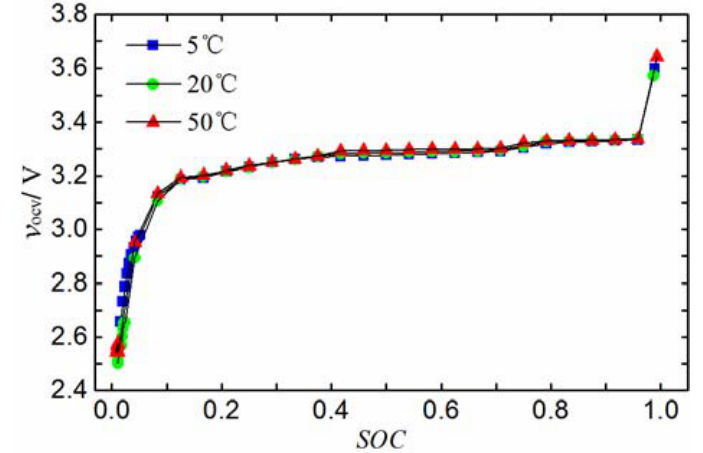
Figure 2. OCV–SoC characteristic mapping curve in different temperature. OCV: open circuit voltage; SoC: state of charge.